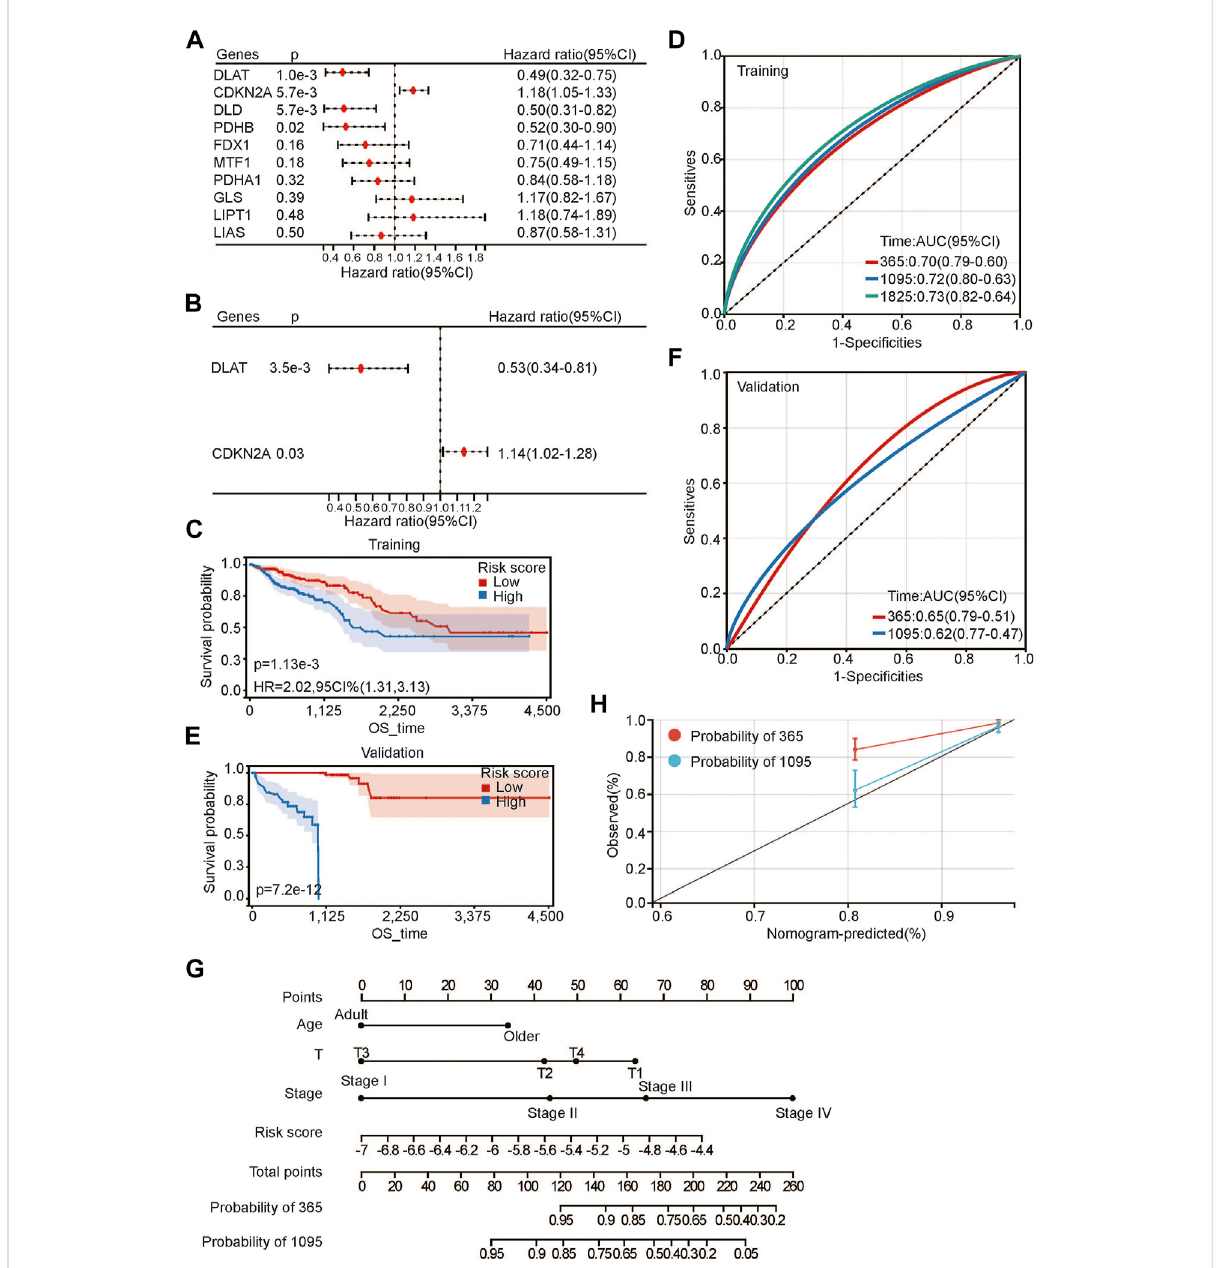
Developing prognosis risk score based on CRGs. (A , B) univariate (A) and multivariate (B) Cox regression analysis of CRGs for OS; (C , E) Kaplan- MeieranalysisofriskscoreforOSintrainingset (C) andvalidationset (E) ; (D , F) ROCanalysisofriskscoreforOSintrainingset (D) andvalidationset (F) ; (G) Nomogram construction of OS based on risk score and clinical characteristics; (H) Calibration curve analysis for constructed